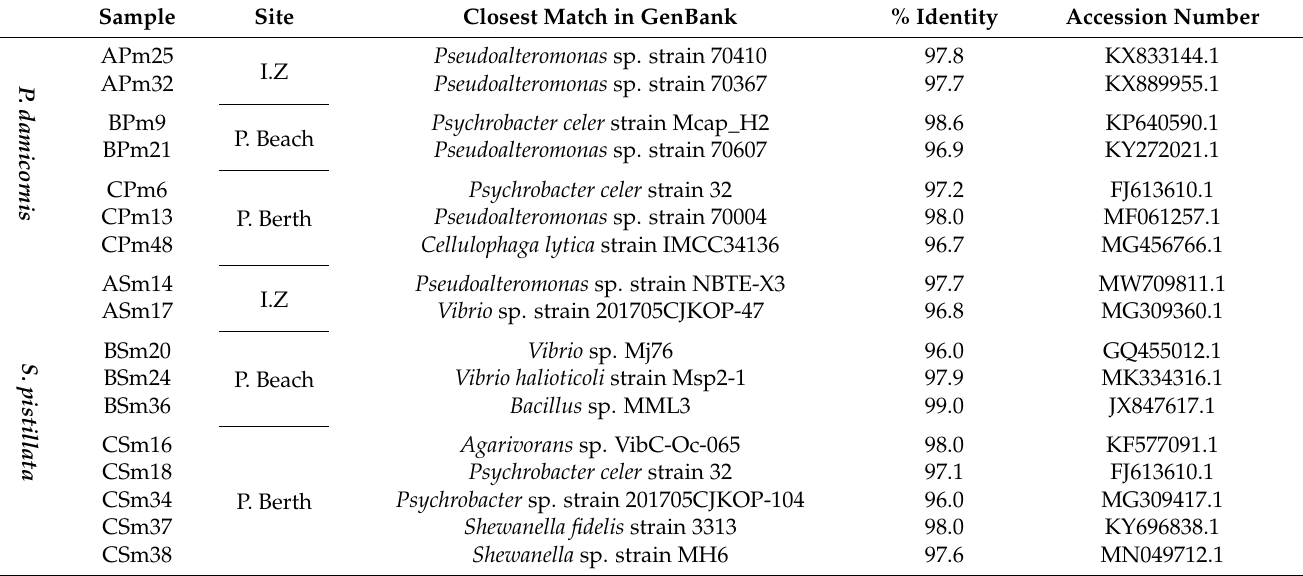
Table 1. Identification of coral mucus-associated bacterial isolates based on 16S rRNA gene identity.